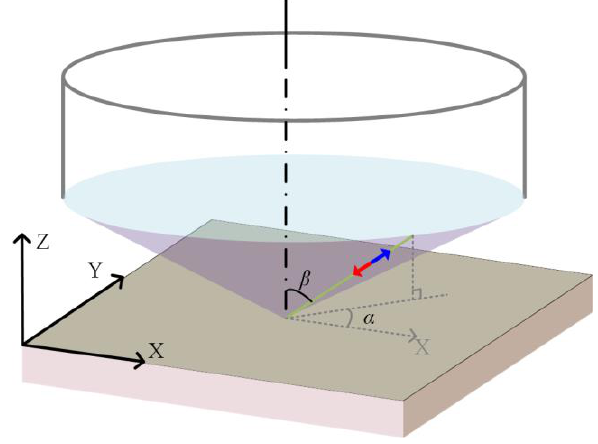
Figure 3. Diagram of the Raman intensity integration with a large-NA objective lens. The relationship between the measured Raman shift ∆ ω obs and the increment of each phonon Raman shift ∆ ω k weighted by their respective contributions to the total scattering intensity is shown in Equation